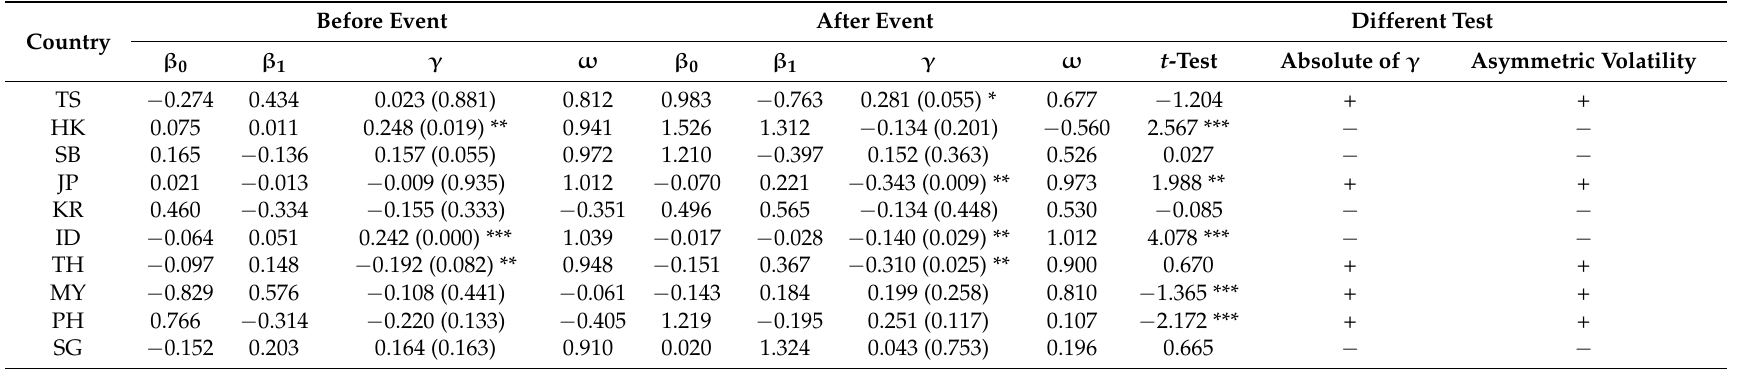
Table 16. The EGARCH model results: global financial crisis.